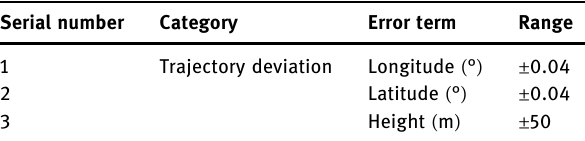
Table 2: Error source setting of trajectory to be identi fi ed Serial number